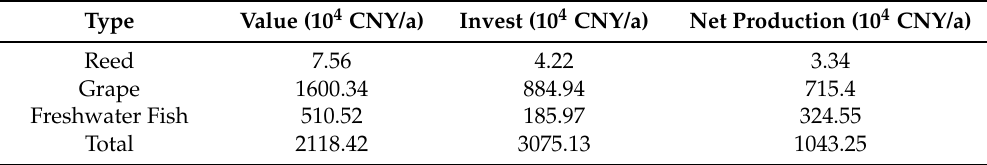
Table 5. The net material production value of Lakeside Wetland